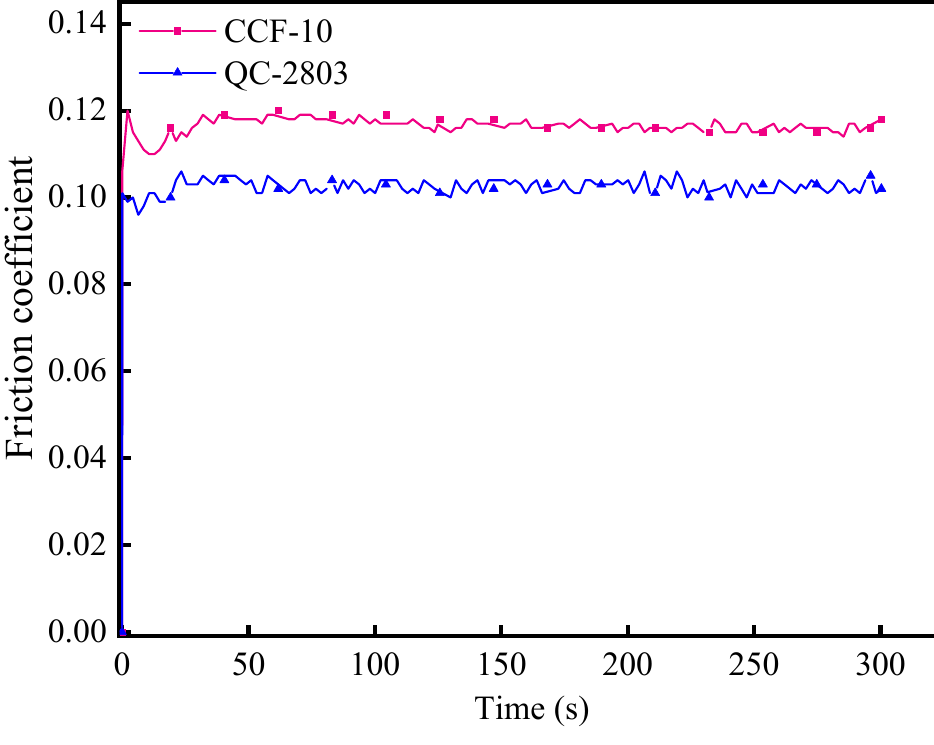
Figure 5. Friction coefficients of CCF-10 and QC-2803.